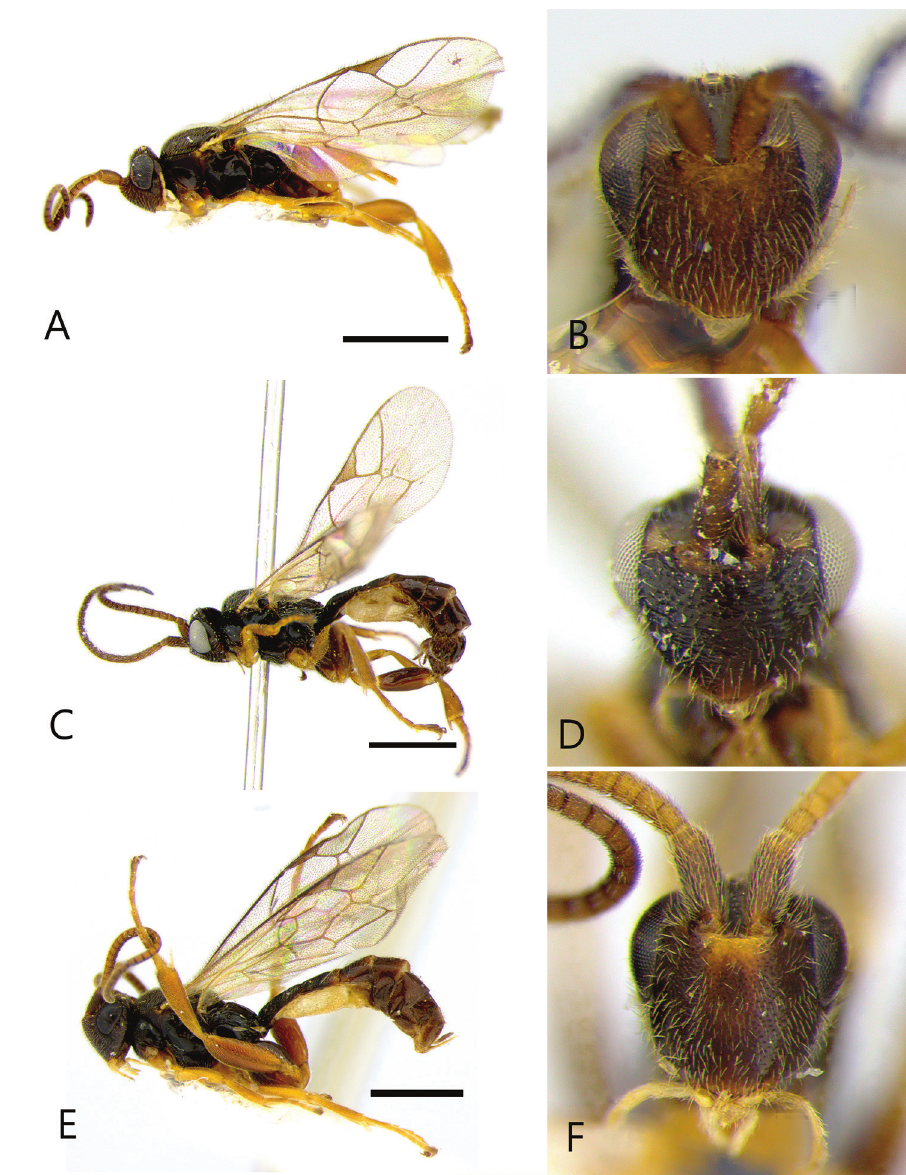
Figure 14. Orthocentrus spp. A Habitus in lateral view of O. protervus B head in frontal view of O. pro- tervus C habitus in lateral view of O. sannio D head in frontal view of O. sannio E habitus in lateral view of O. spurius F head in frontal view of O. spurius